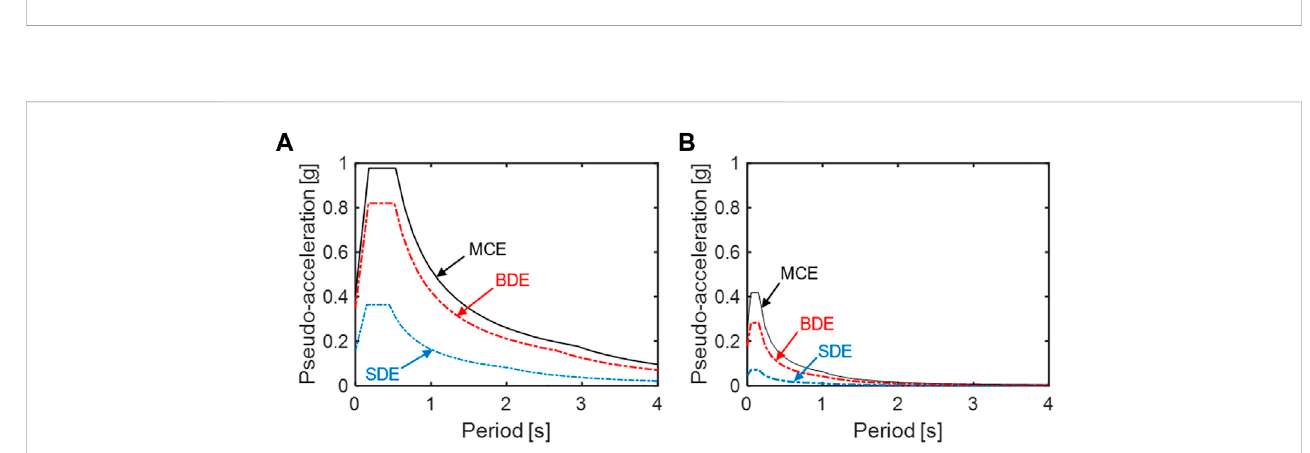
FIGURE 5 Horizontal (A) and vertical (B) pseudo-acceleration elastic response spectra for L ’ Aquila — SDE, BDE, and MCE hazard